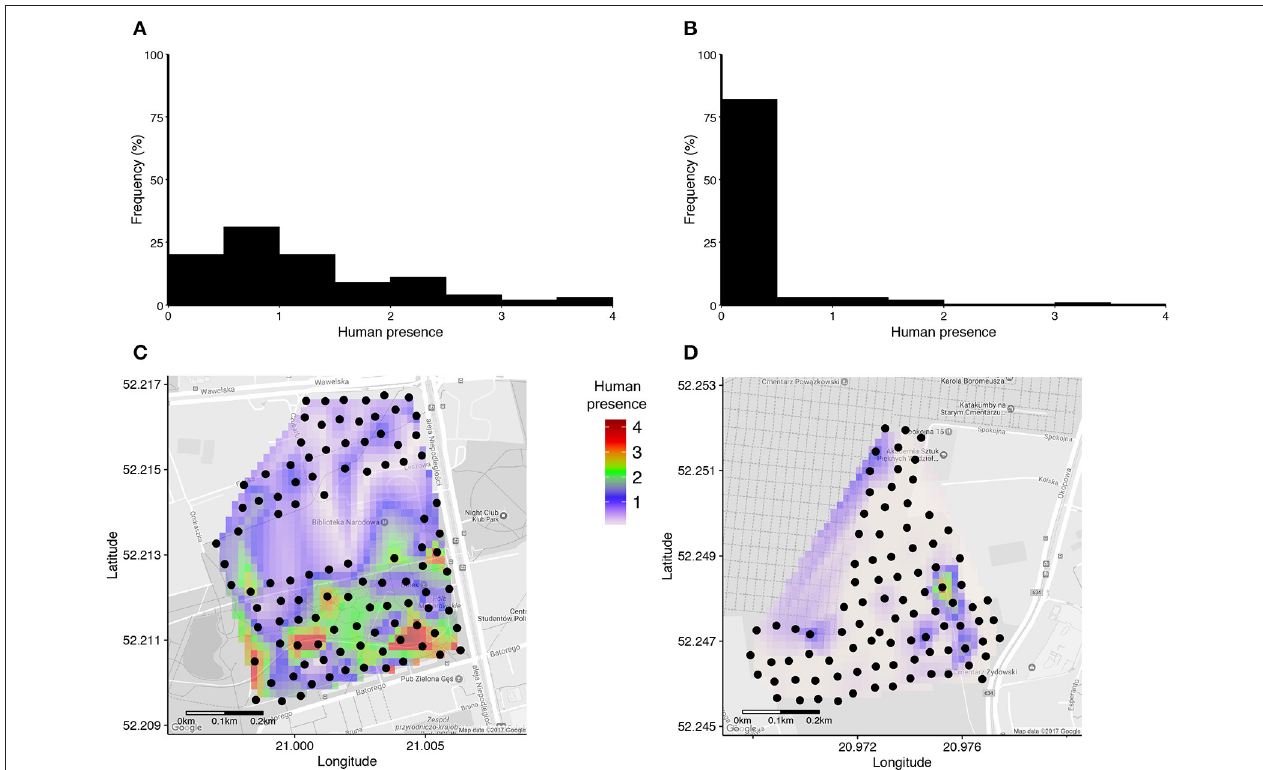
FIGURE 1 | (A,B) Histograms of average human presence around each nestbox in the urban park (A) and in the cemetery (B) . Average human presence was calculated as the total number of humans and dogs in a 15 m radius to each nestbox standardised by the number of counts performed within each site (i.e., N = 48 in A , N = 18 in B ). (C,D) Interpolated maps of average human presence around each nestbox (black dots) are indicated for the urban park (C) and the cemetery (D) , respectively.